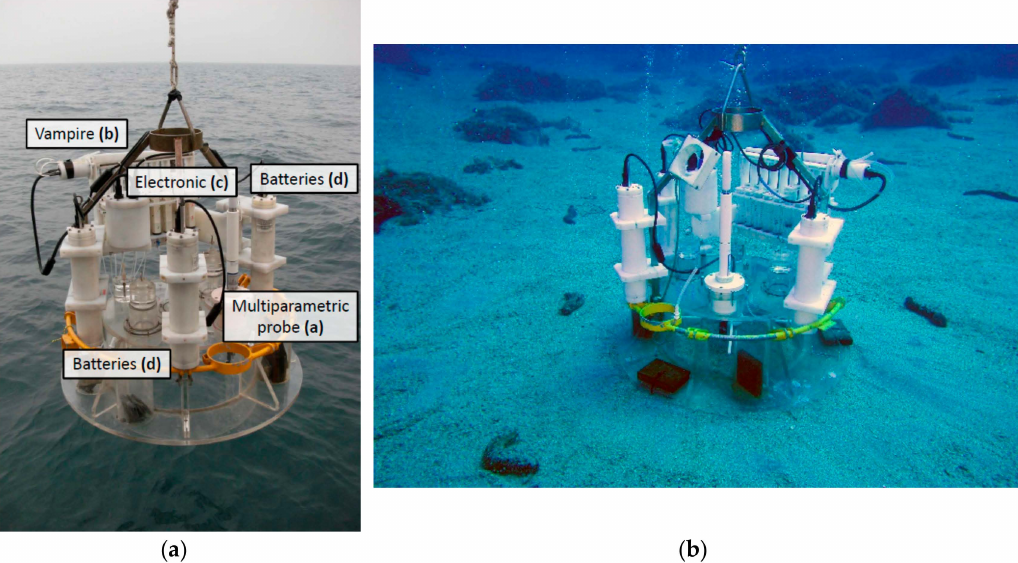
Figure 14. The Automatic Benthic Chamber during ( a ) deployment and ( b ) operational on the seabed with various instruments: Multiparameter probe; VAMPIRE; electronics case; and battery pack